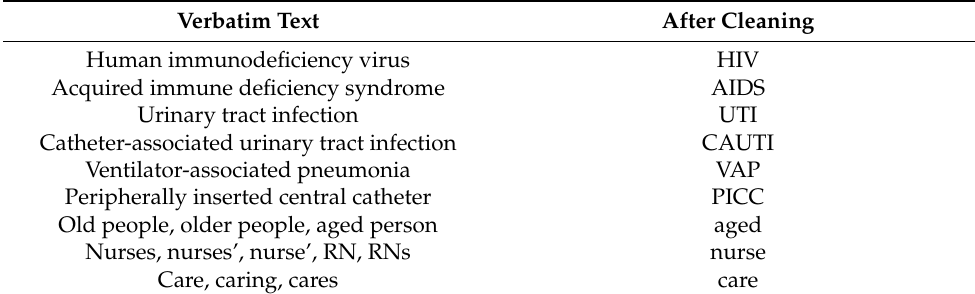
Table 1. Examples of data